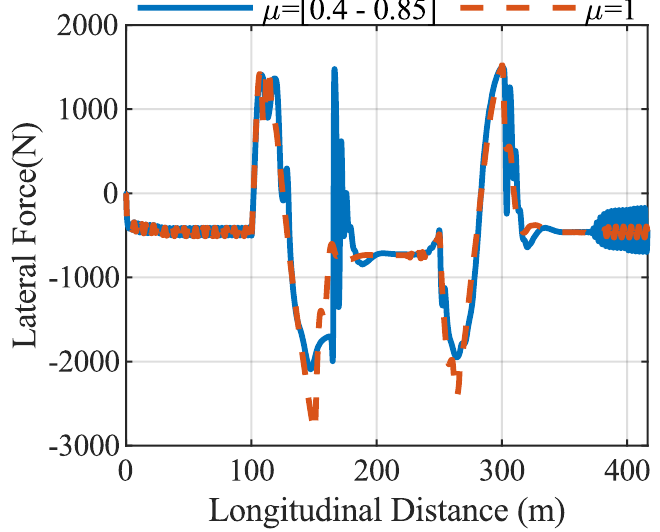
Figure 9. The behavior of lateral force for v x = 100 km/h for a variety of road conditions, µ ∈ [ 0.4–0.85 ] and µ =